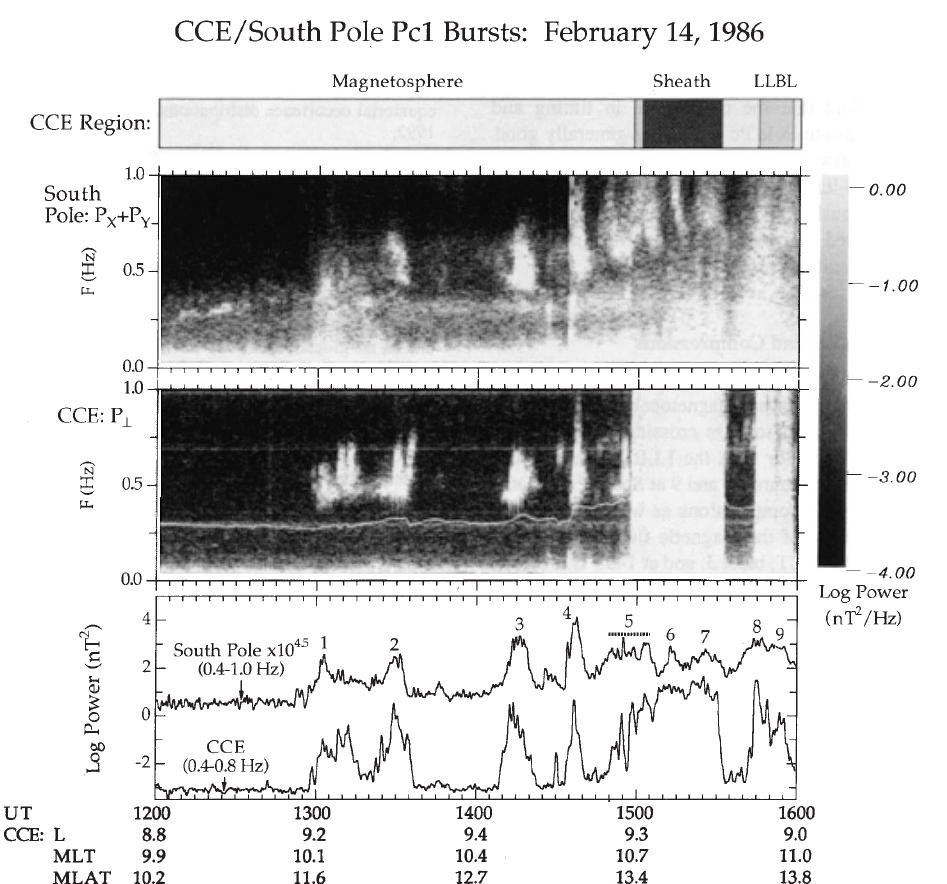
Fig. 15. Simultaneous observa- tions of Pc 1 bursts in the outer magnetosphere by the AMPTE/ CCE satellite and at South Pole. The ground station was located near the geomagnetic field foot- print of the satellite (reproduction of Fig. 3 of Anderson et al